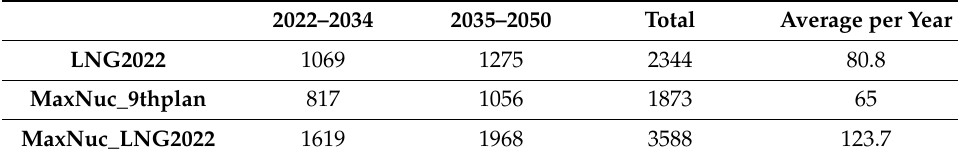
Table 4. Summary of avoided MTCO 2 e GHG emissions compared to